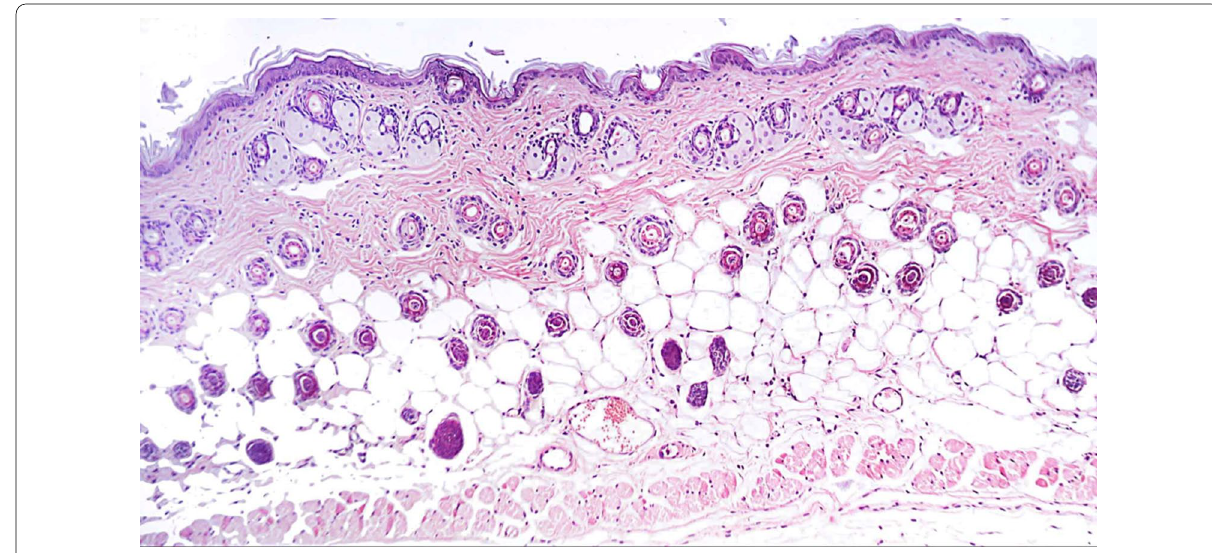
Fig. 2 Histopathology of normal skin tissue section (Group N) showing normal intact skin layers including epidermis, dermis and subcutaneous fat and muscles (H&E